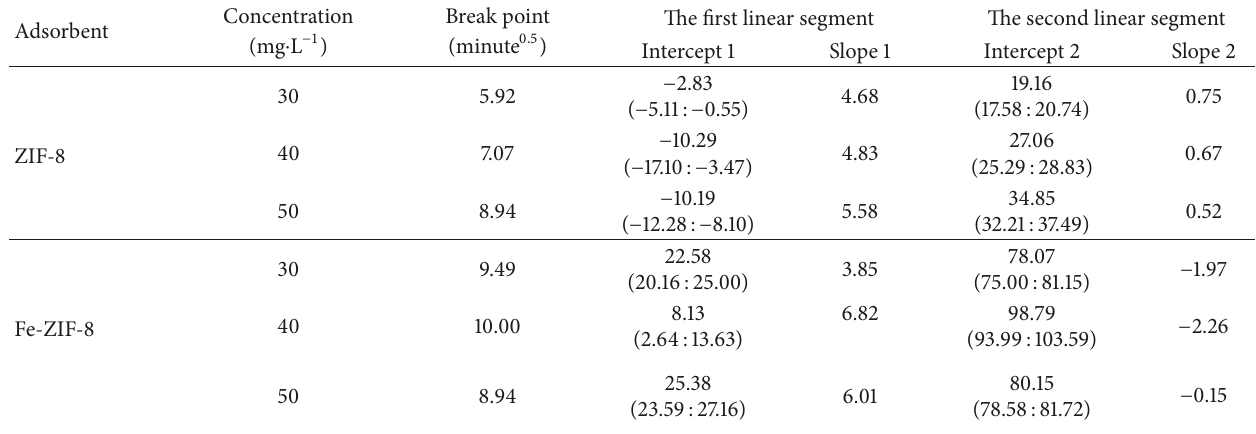
Table 4: Results of piecewise regression for the two linear segments for ZIF-8 and Fe-ZIF-8 (the values in parentheses are at a 95% confidence